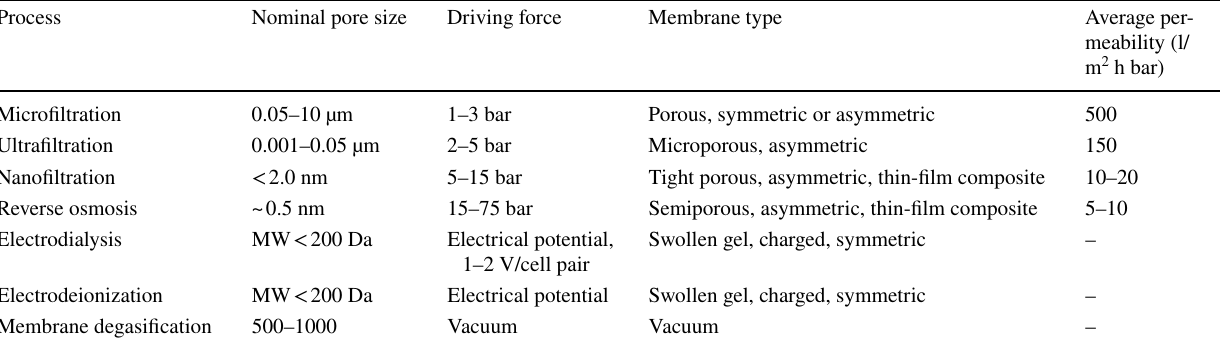
Table 3 Classification and characteristics of membrane processes used in water treatment Process Nominal pore